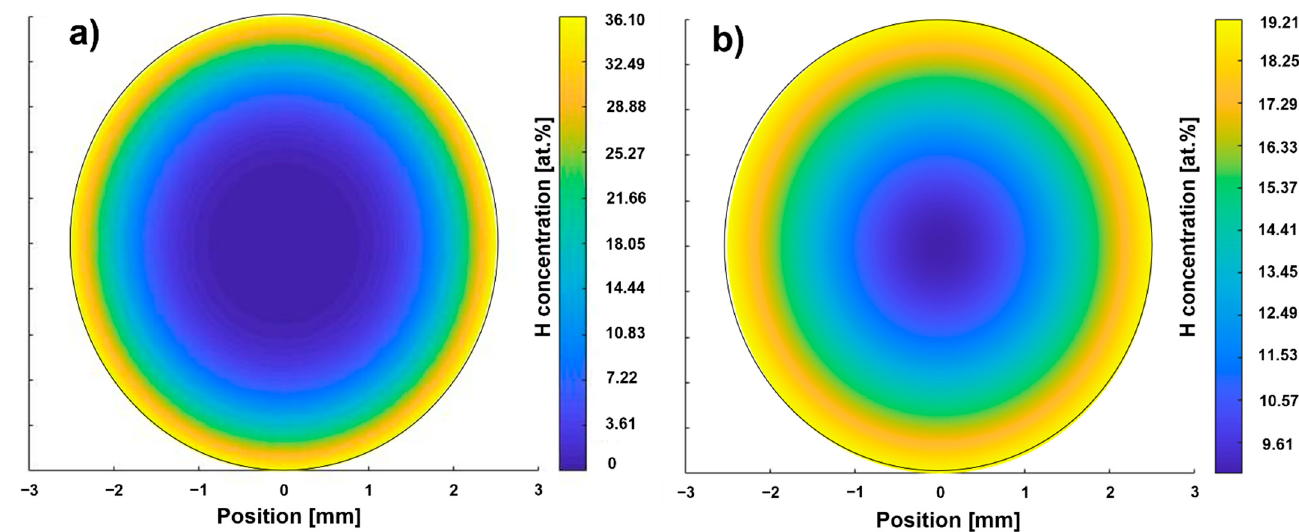
Figure 3. Calculated hydrogen concentration profiles according to path A ( a ) and B ( b ).